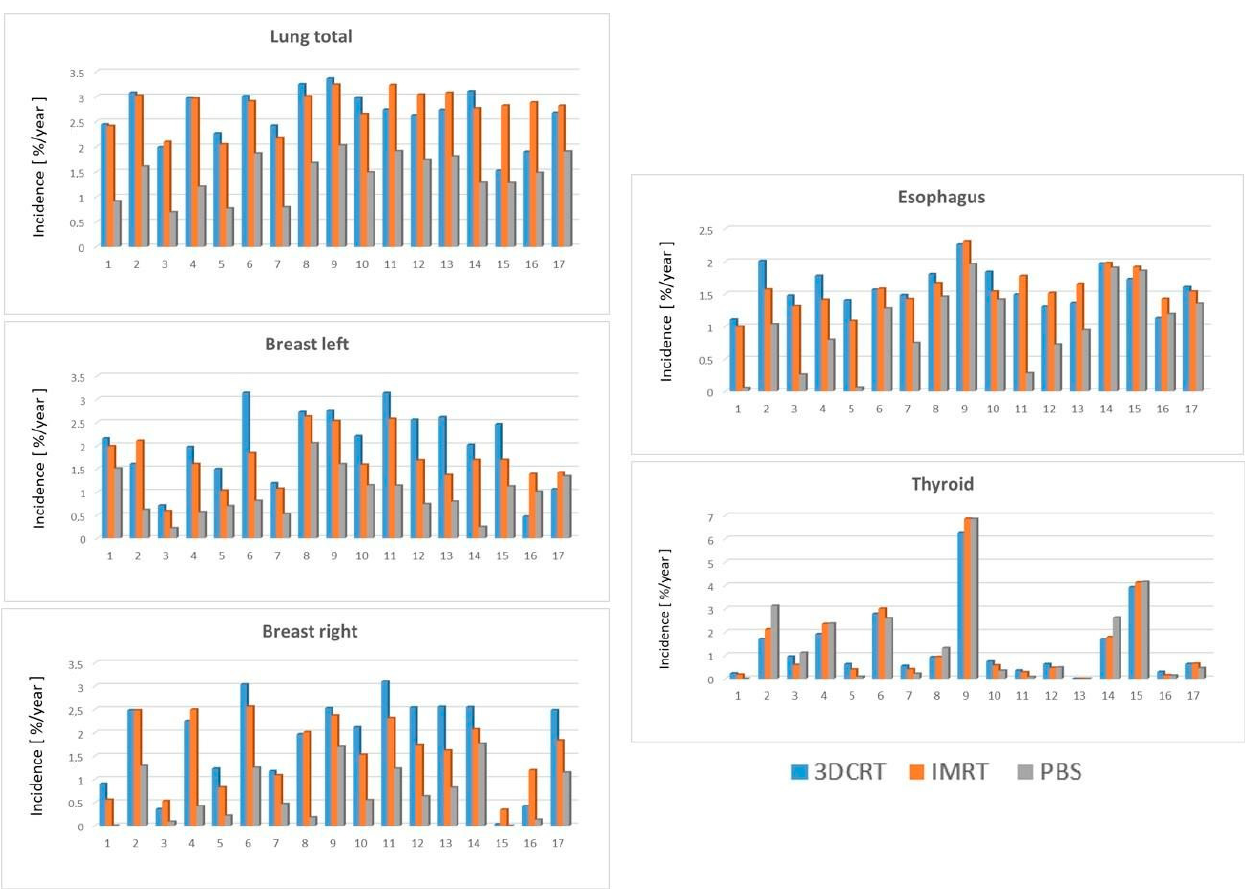
Figure 2. The organ ‐ specific cancer incidence rates per 10,000 patients per year per Gy (lung, left and right breast, as well as esophagus and thyroid) according to the Schneider ‐ model for 3DCRT (blue), IMRT (red), and PBS (grey) plans for each patient. Table 5. Median values (range) of the predicted secondary malignancy rates per 10,000 patients per year per Gy using the Schneider model for the different techniques.